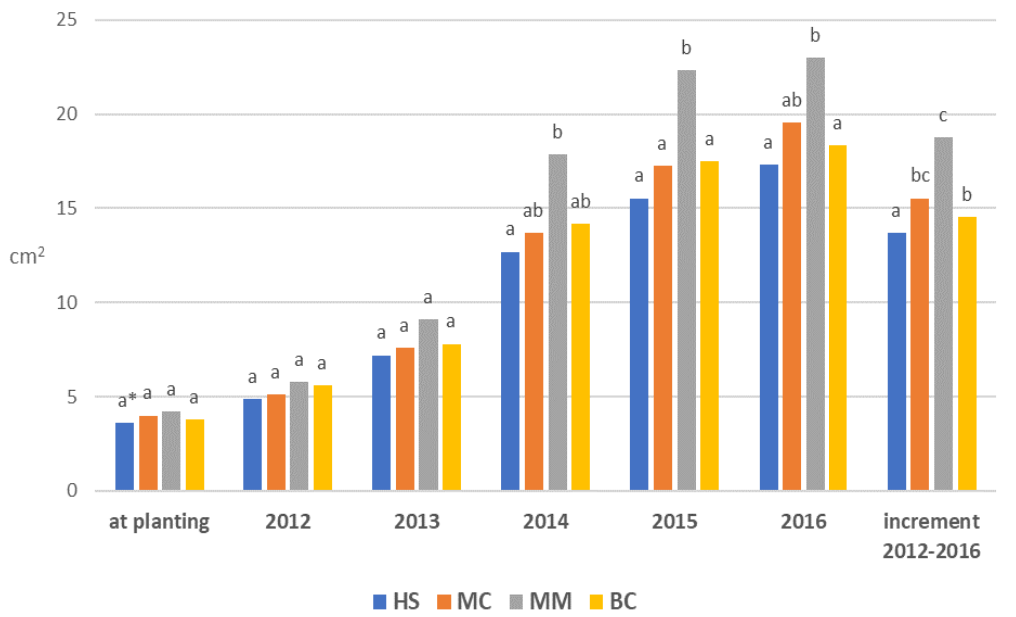
Figure 2. Trunk cross-section area (TCSA) and TCSA increment of apple tree cv. Gold Chief using different soil management systems during 2012–2016. HS: Herbicide strip; MC: Mechanical cultivation; MM: Miscanthus spp . mulch; BC: Black polypropylene woven ground cover. * means followed by the same letter within a year do not differ significantly according to the Newman–Keuls test at p < 0.05.